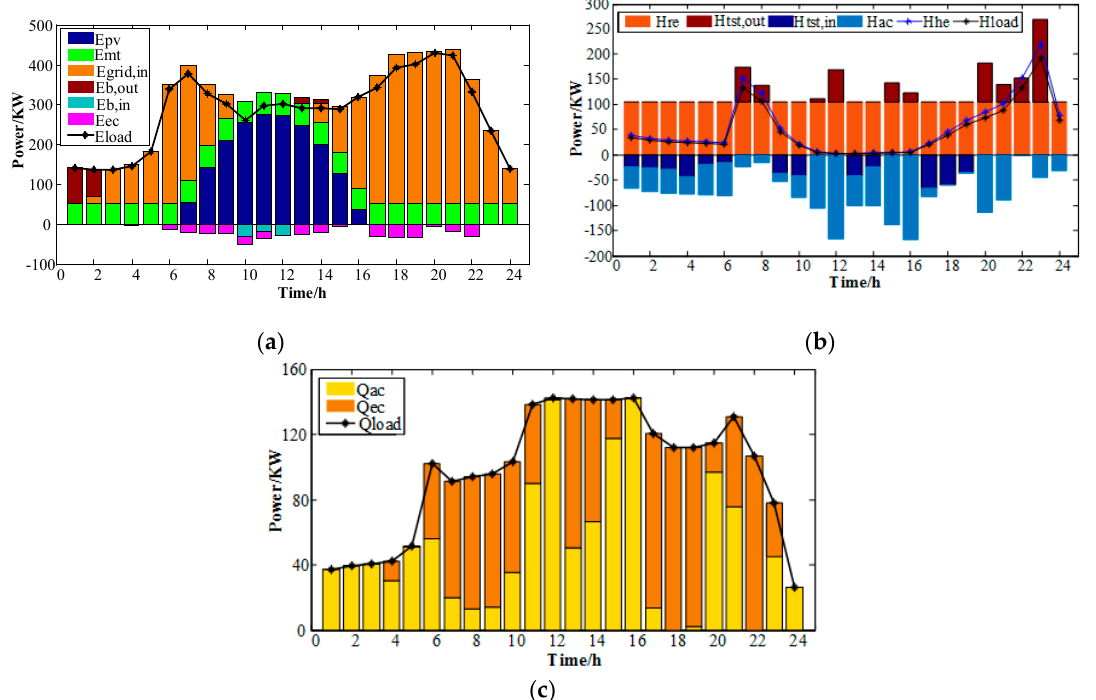
Figure 9. Power balance diagram under the IFHL strategy: ( a ) Electric load balance; ( b ) Heat load balance; ( c ) Cold load balance.